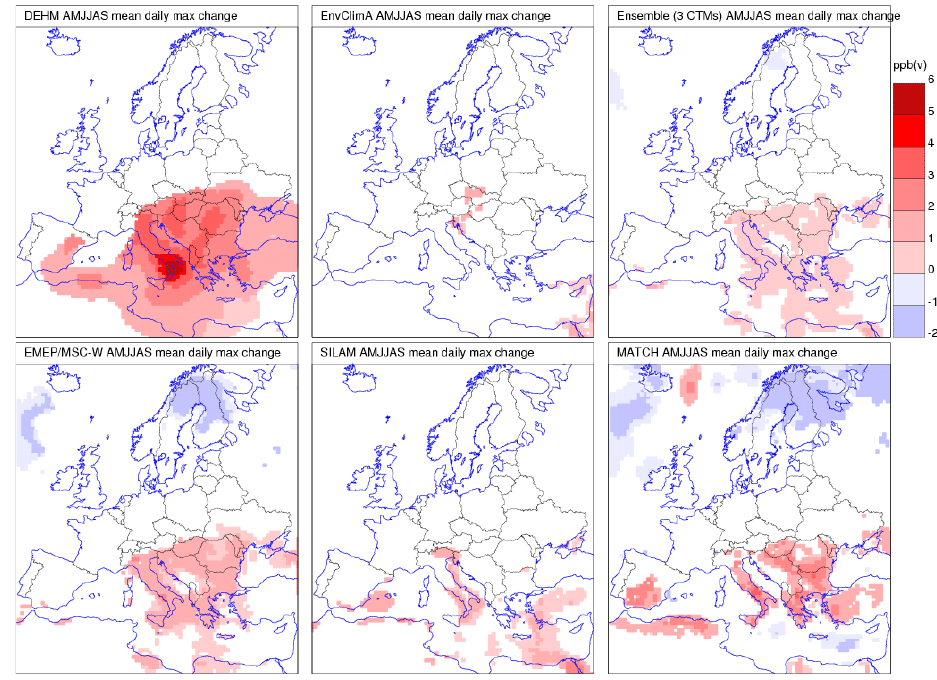
Fig. 10. Simulated April–September change 2000–2009 to 2040–2049 in average daily maximum O 3 concentration at the first model level. Only changes that are statistically significant at the 95% level are plotted. Units